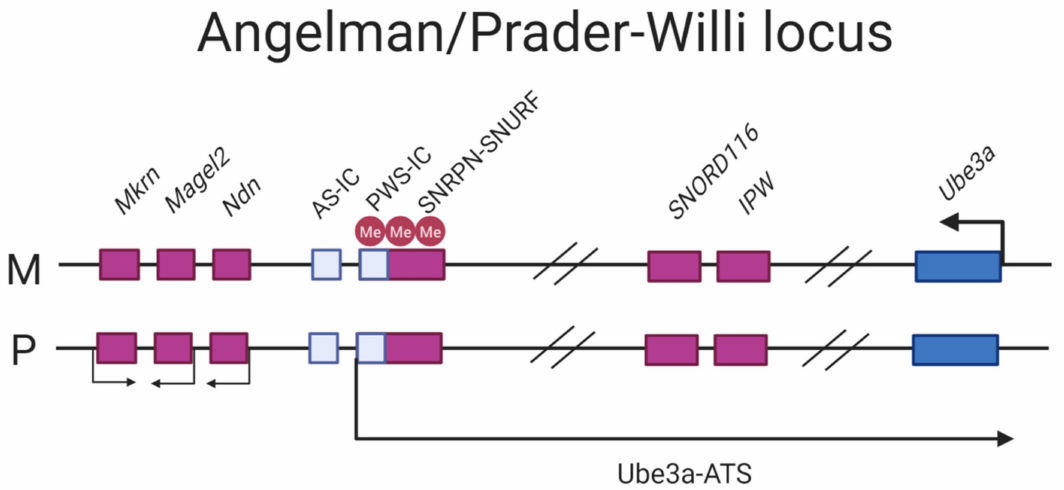
Figure 4. Schematic of the AS / PWS locus. The pink filled boxes: paternally expressed genes, blue filled boxes: maternally-expressed genes. The PWS / IC located in the promoter / exon 1 region of SNRPN / SNURF ishypermethylatedonthematernallyinheritedchromosomethussilencingtranscription of the Ube3a-ATS, allowing Ube3a to be expressed. The paternally-inherited PWS-IC is hypomethylated thus expressing the transcript, silencing Ube3a